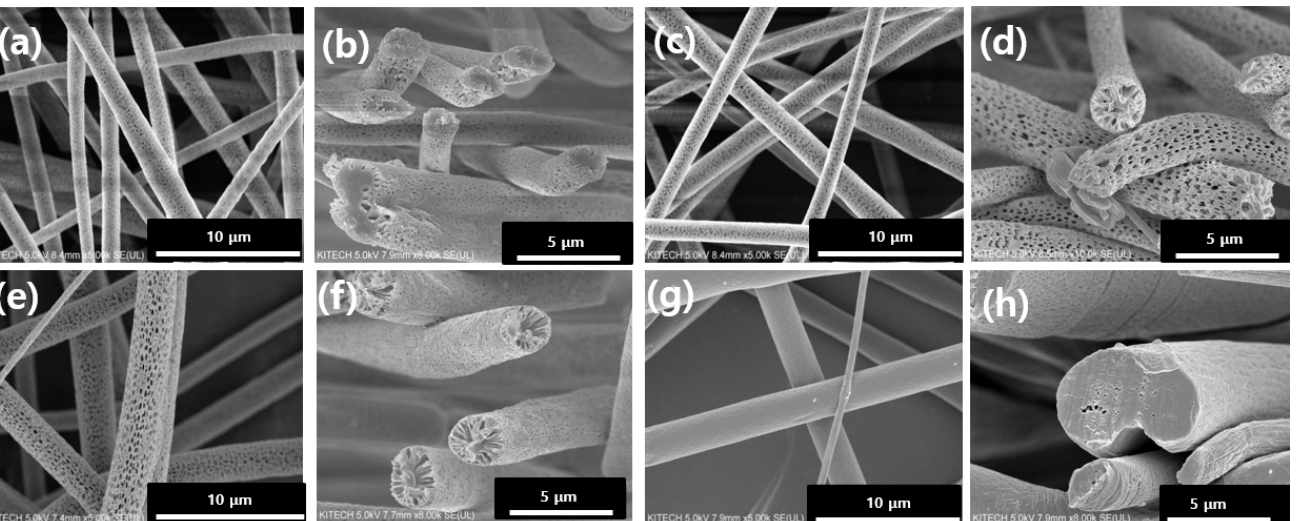
Table 1. Physical properties of electrospun non-porous and porous PLA fibers.